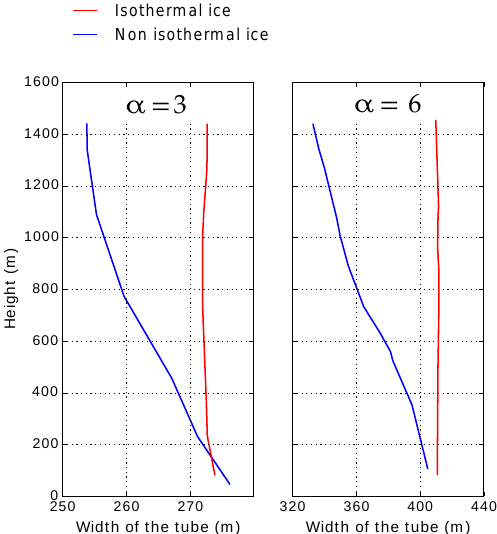
Figure 8. Width of the flow tube (m), for the isothermal (red) and non-isothermal case (blue), for α = 3 ( x = 1500m, left) and α = 6 ( x = 1200m, right). The aspect of the curves is slightly affected by numerical noise due to